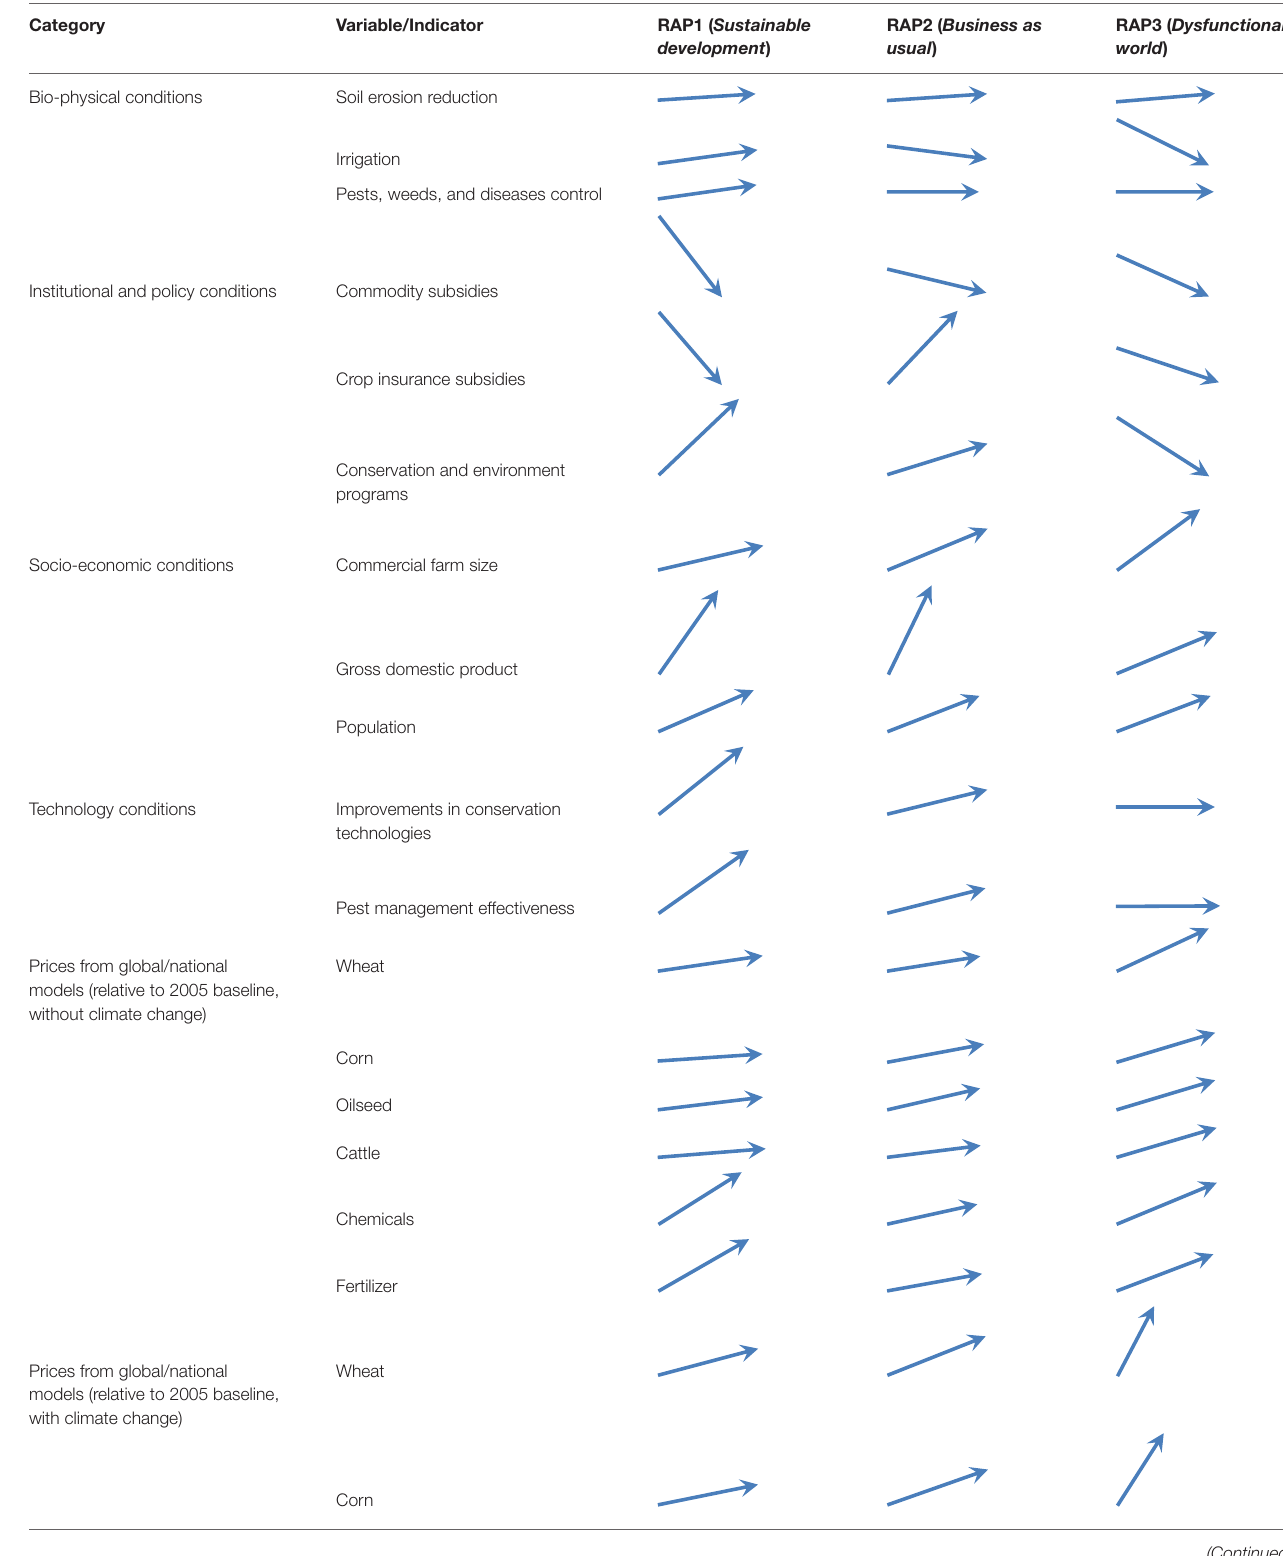
TABLE 1 | Likely trends of variables for REACCH